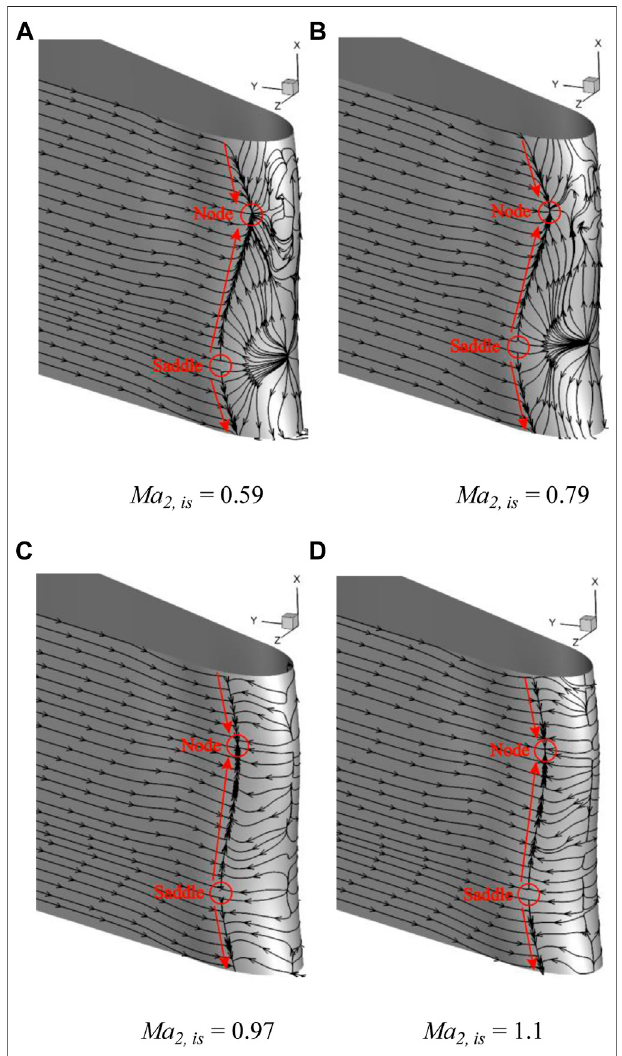
FIGURE 11 | Time-averaged surface streamlines in the trailing edge region of different Mach numbers. (A) Ma 2 , is (cid:1) 0 . 59 (B) Ma 2 , is (cid:1) 0 . 79. (C) Ma 2 , is (cid:1) 0 . 97 (D) Ma 2 , is (cid:1) 1 . 1.